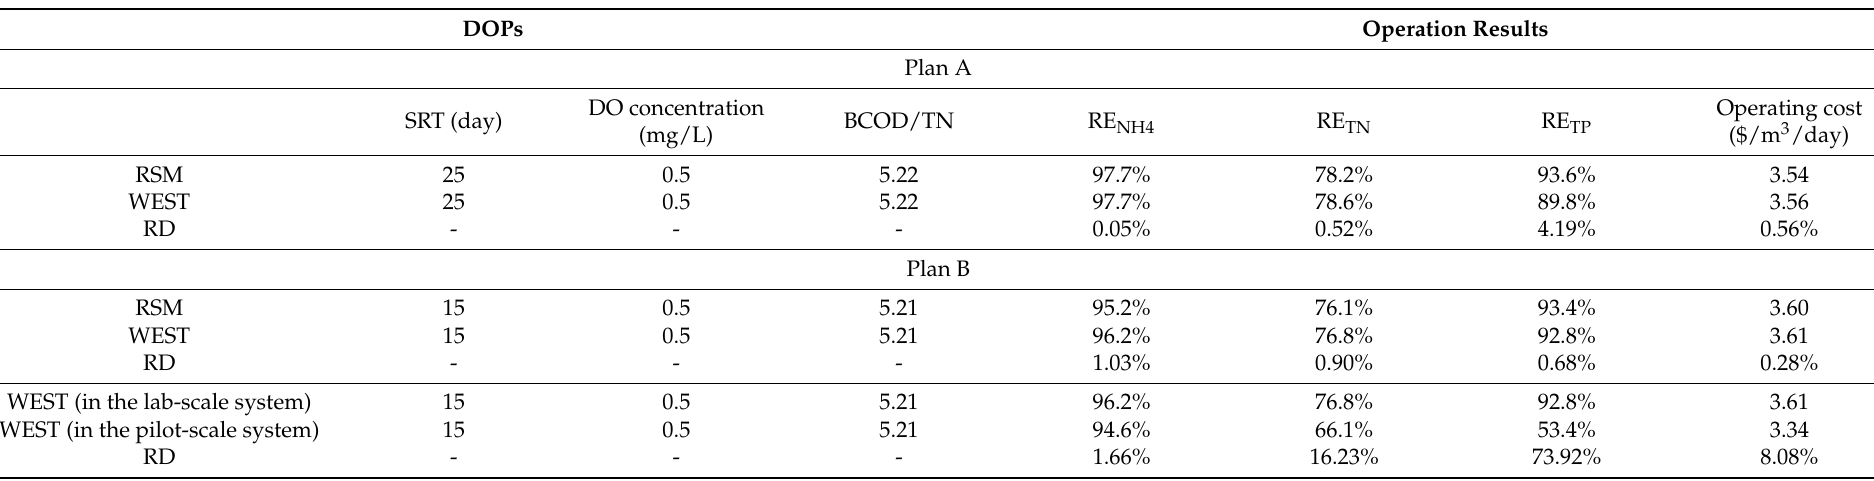
Table 5. Comparison between the predicted results by RSM and ASM2d on the WEST ® platform (Plan A and Plan B) as well as the simulated results of ASM2d in different scales under the optimal